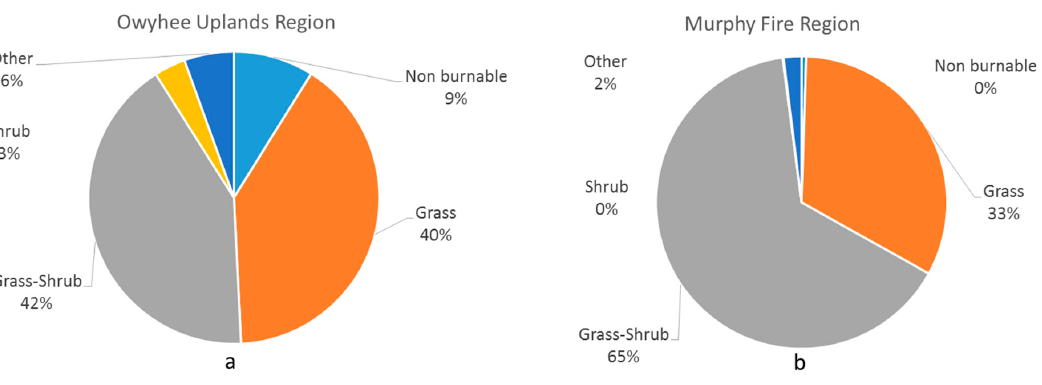
Figure 2. Percentage of area in LANDFIRE fuel types in the Owyhee region ( a ) and the Murphy fire region ( b ).